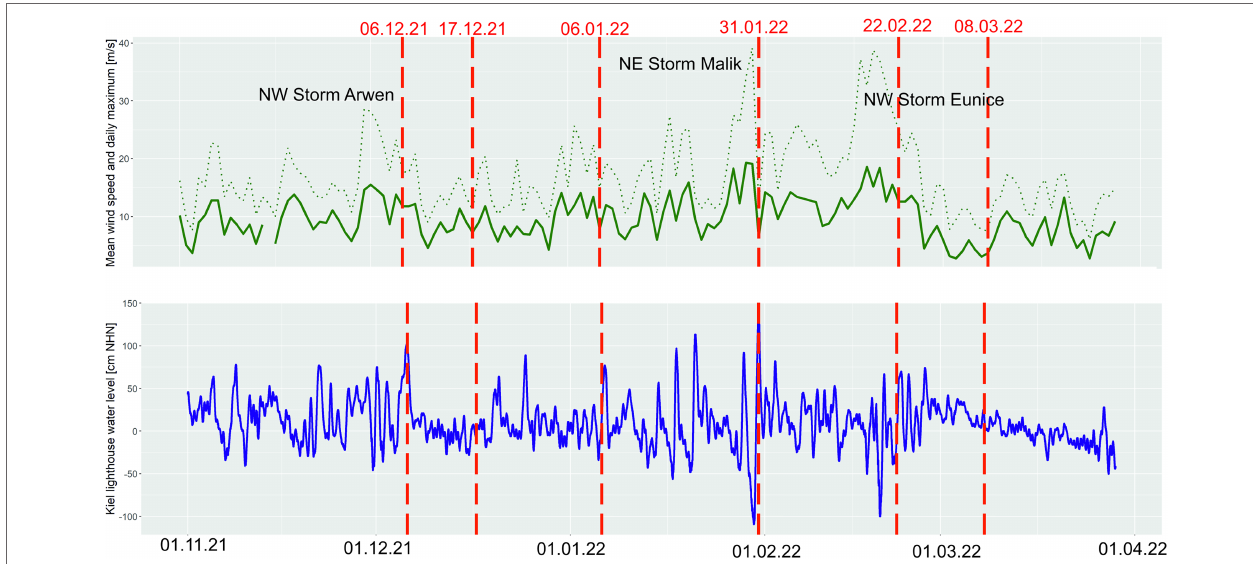
FIGURE 3 | The monitoring period covered the major storm events Arwen, Malik, and Eunice. Green line displays mean wind speed [m/s] and green dotted line displays maximum wind speed [m/s]. Blue line shows water level fluctuations [cm NHN]. Dates for UAV flights are displayed as red dotted vertical lines